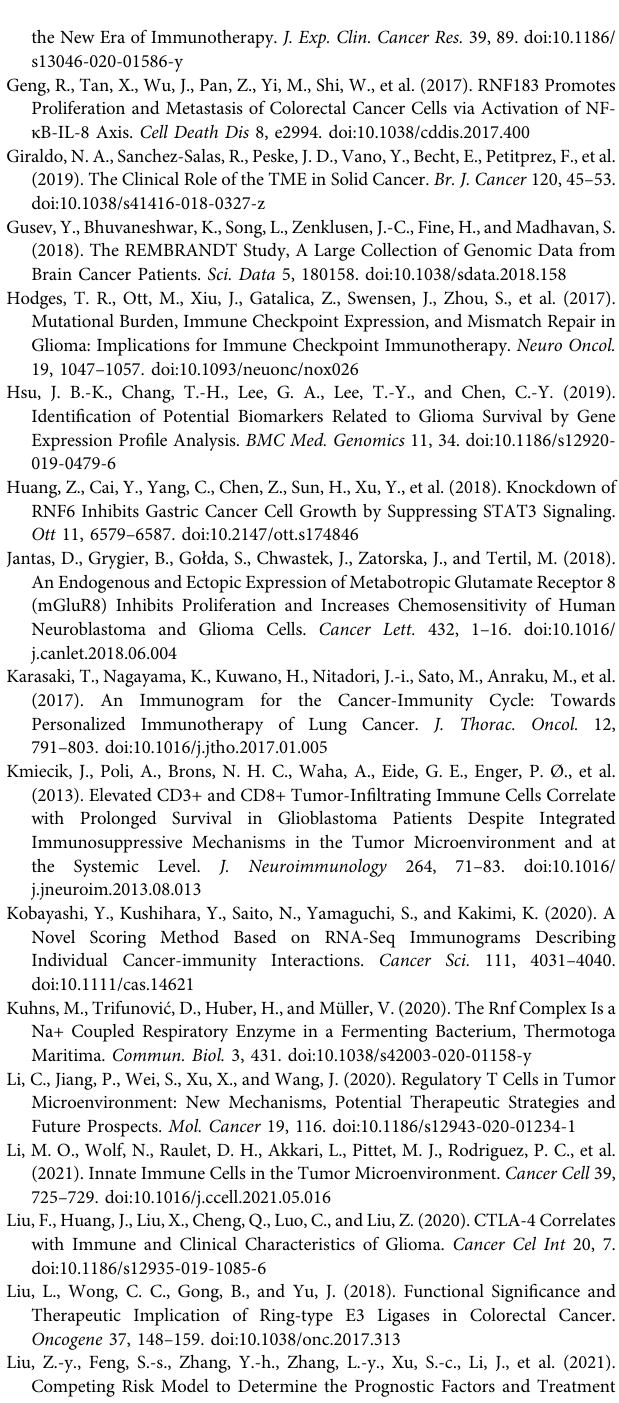
Supplementary Figure S7 | Enrichment of signaling pathways based on the expression of three main contributors. GO enrichment analysis based on GSVA analysis of TRIM8 (A) , DTX2 (B) , and TRAF5 (C) . Supplementary Table S1 | Total RNF family gene list from HGNC database. Supplementary Table S2 | The clinicopathological characteristics of four public databases. Supplementary Table S3 | Top 50 predicted drugs from the Cellminer